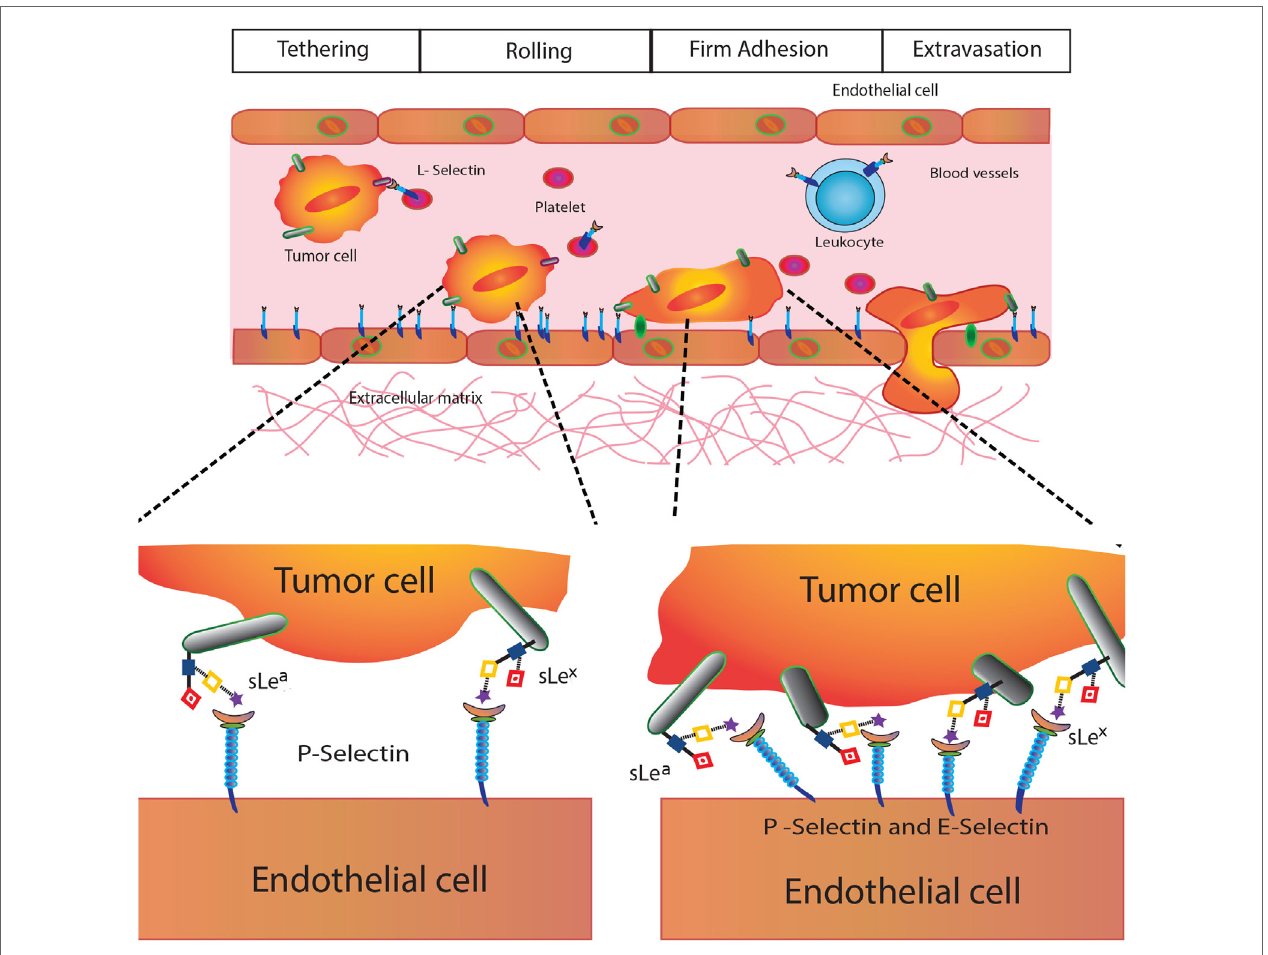
FiGURe 4 | Selectins in cancer biology . Selectins play different roles in tumor biology including modulation of platelet–cancer cell interactions (P-selectin), promotion of tumor cell adhesiveness, extravasation and metastasis (E-selectin), and leukocyte trafficking and hematogenous metastasis